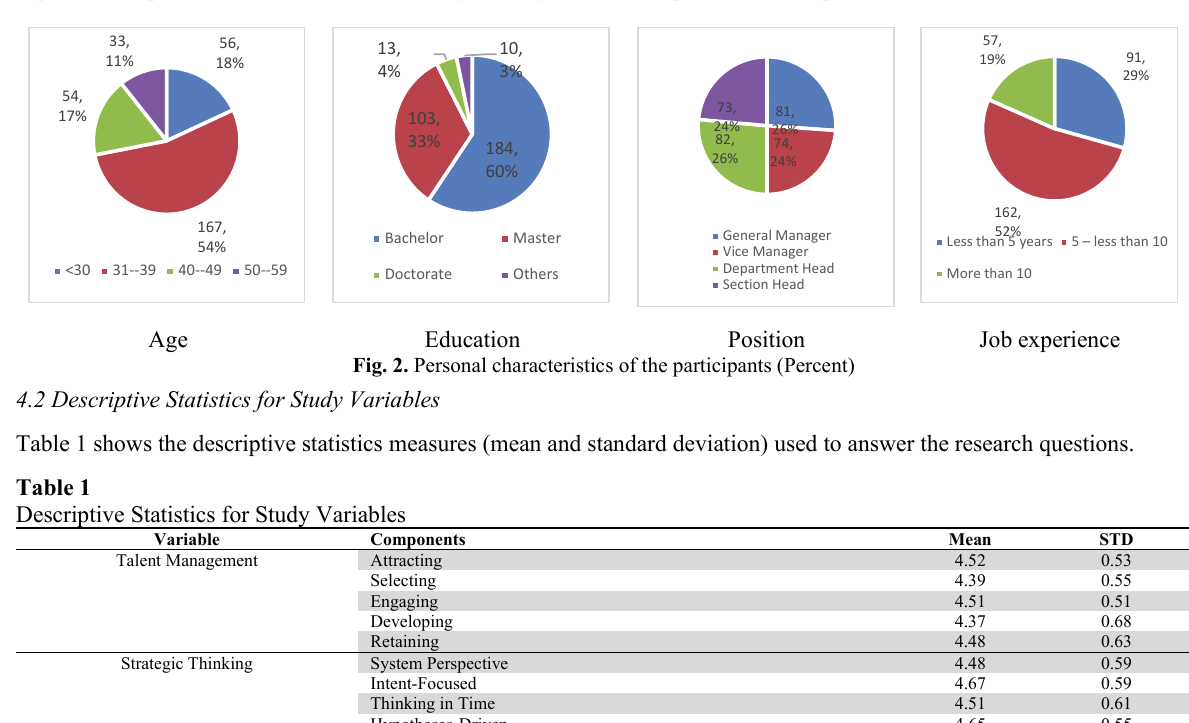
Fig. 2 lists respondents’ characteristics with regard to age, education, position, and experience.